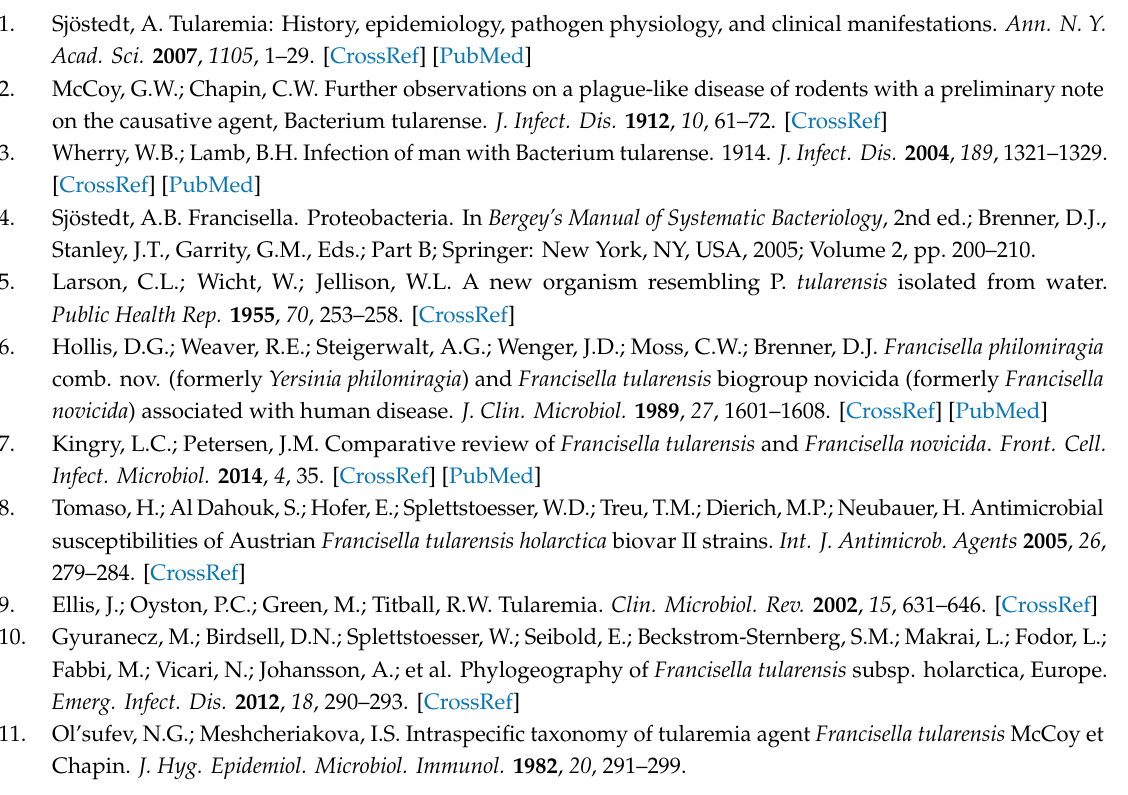
Figure S1: Ulceroglandular infection with F. tularensis originating from an infected brown hare (a) and ulcer in the palm of patient 1 (b) acquired in Tyrol in